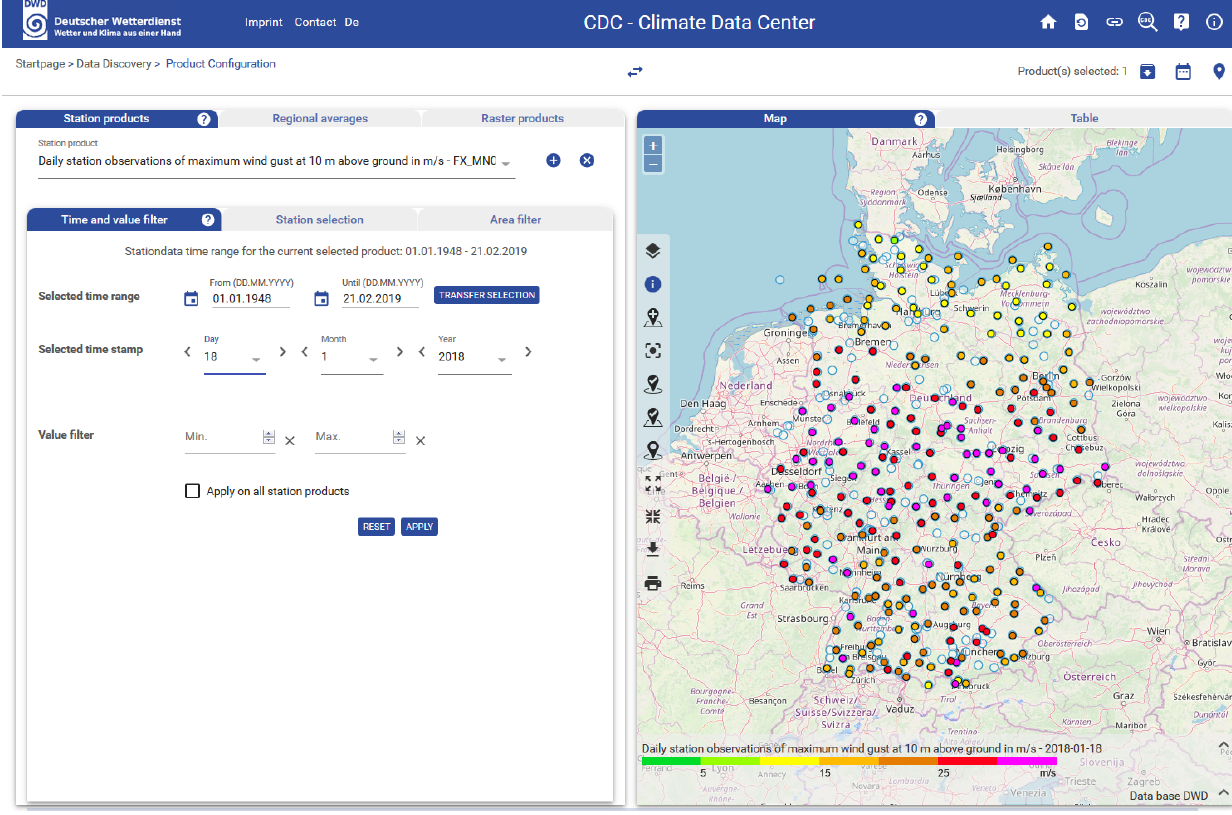
Figure 3. Interactive components of the portal with configuration area (left part) and map display area (right part). The example shows daily maximum wind gusts of 18 January 2018 (Cyclone Frederike) (Source: Deutscher